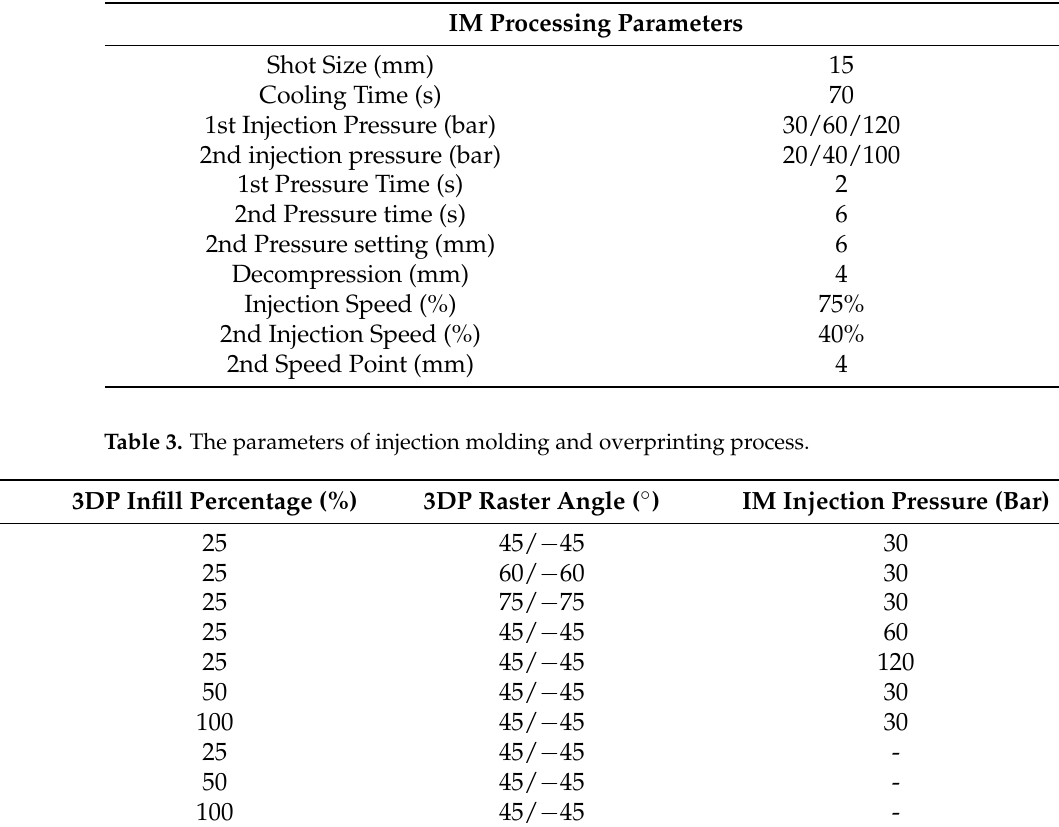
Figure 1. ( a ) Designed profile of the injection mold tool; ( b ) finished product of each injection molding cycle. Table 2. IM processing parameters for IM tablets.